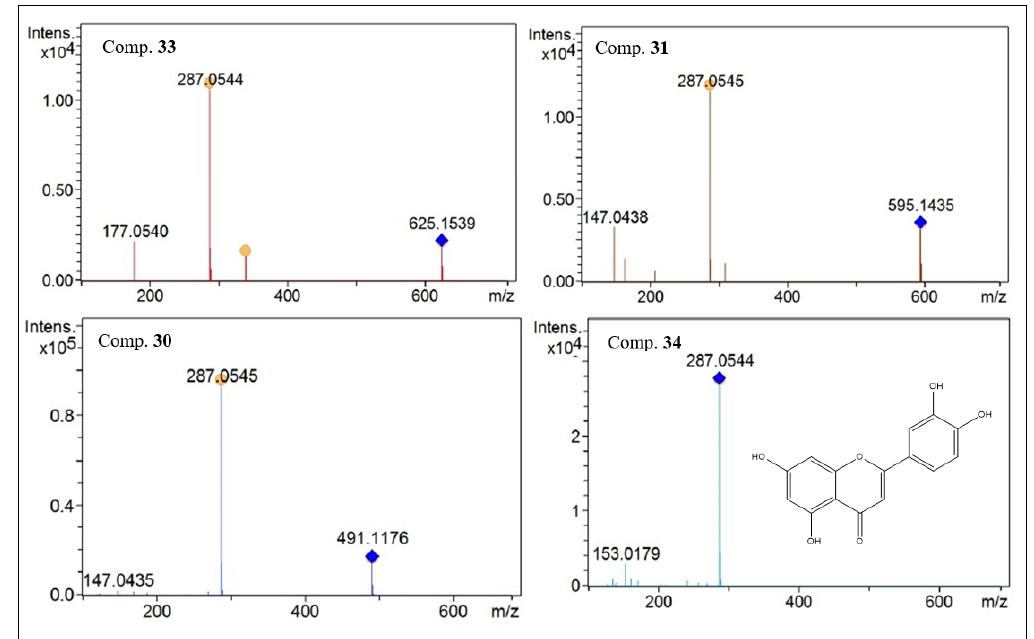
Figure 7. MS 2 spectra of flavones with luteolin-like aglycones present in the ethanolic extract of F. chica leaves. F. chica